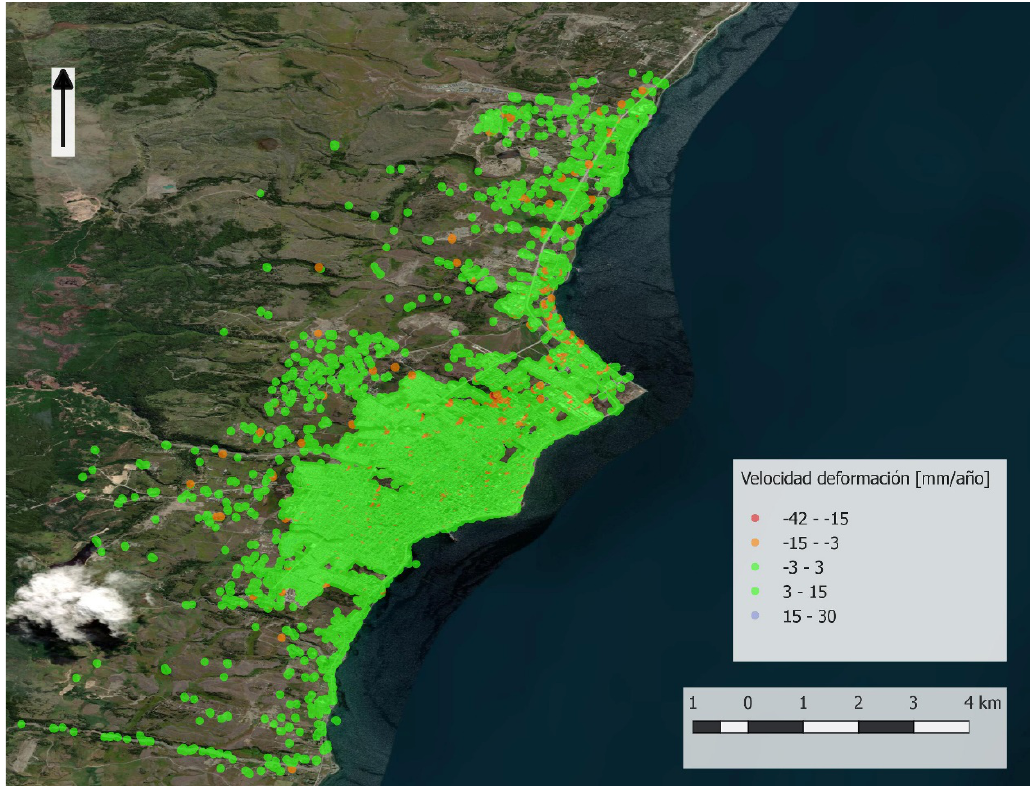
Figure 2. Displacement velocity map of Punta